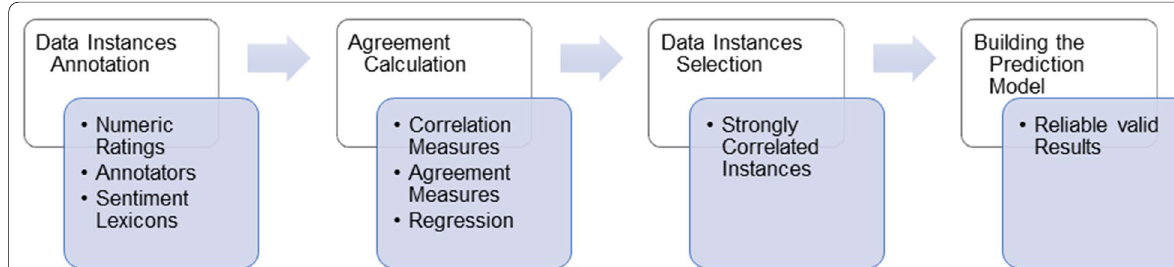
Fig. 4 The enhanced model for prediction models